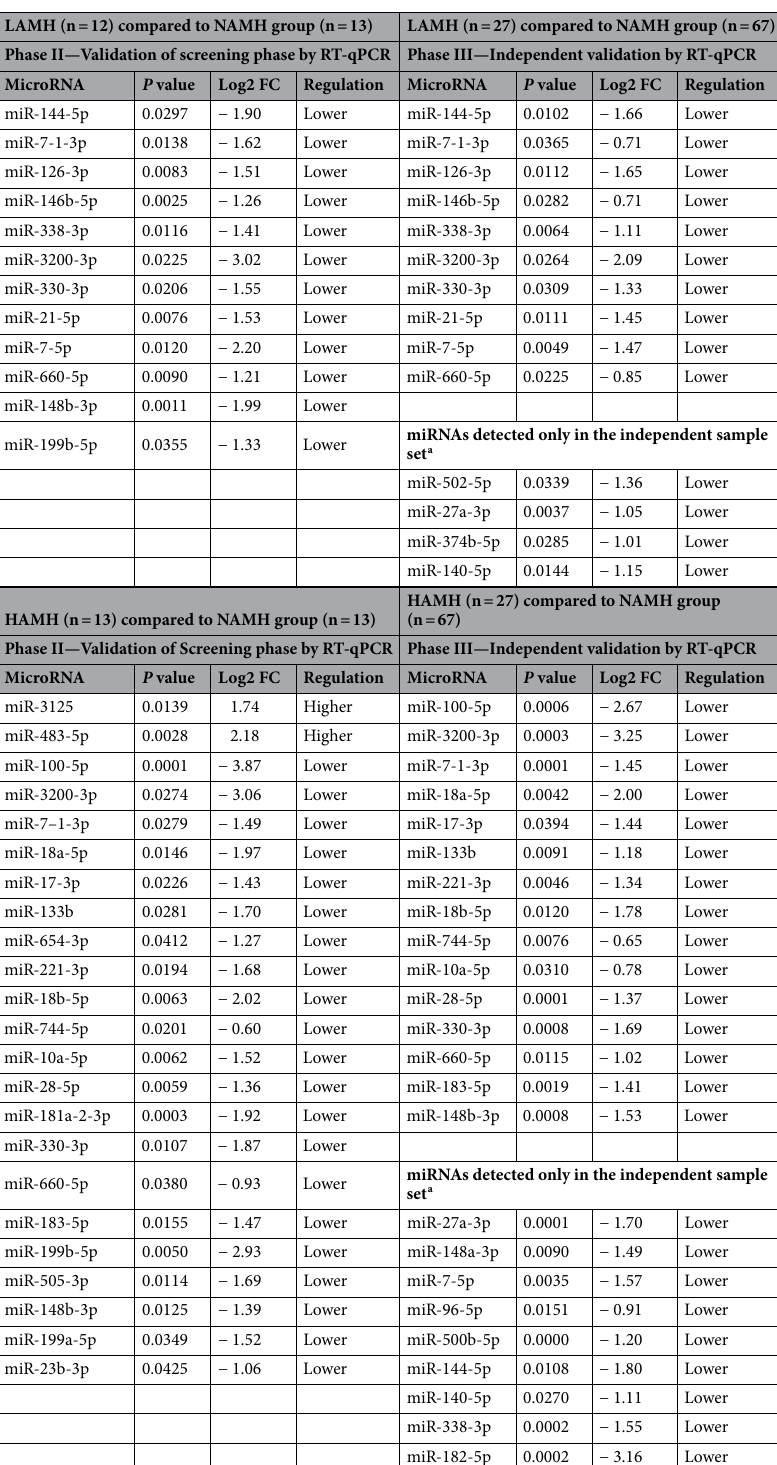
Table 3. Validation of the abundant miRNAs in the blood of women presenting at an infertility clinic as determined by RT-qPCR (P < 0.05). LAMH (n = 12) compared to NAMH group (n = 13), HAMH (n = 13) compared to NAMH group (n = 13), LAMH (n = 27) compared to NAMH group (n = 67), and HAMH (n = 27) compared to NAMH group (n = 67). Unpaired t-test was used to calculate the P value. Benjamini–Hochberg correction for multiple testing was used to adjust the P value. P values of < 0.05 was considered statistically significant. Relative abundance level of 2 _ΔΔCt was used for RT-qPCR. LAMH low anti-Müllerian hormone, HAMH high anti-Müllerian hormone, NAMH normal anti-Müllerian hormone, FC fold change. a Additional miRNAs were only detected by RT-qPCR in the independent validation phase and were not previously detected by microarray in the screening